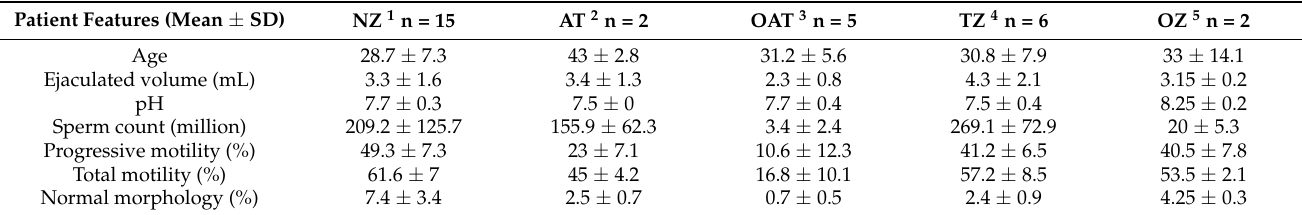
Table 1. Clinical characteristics of the subjects enrolled in the study.